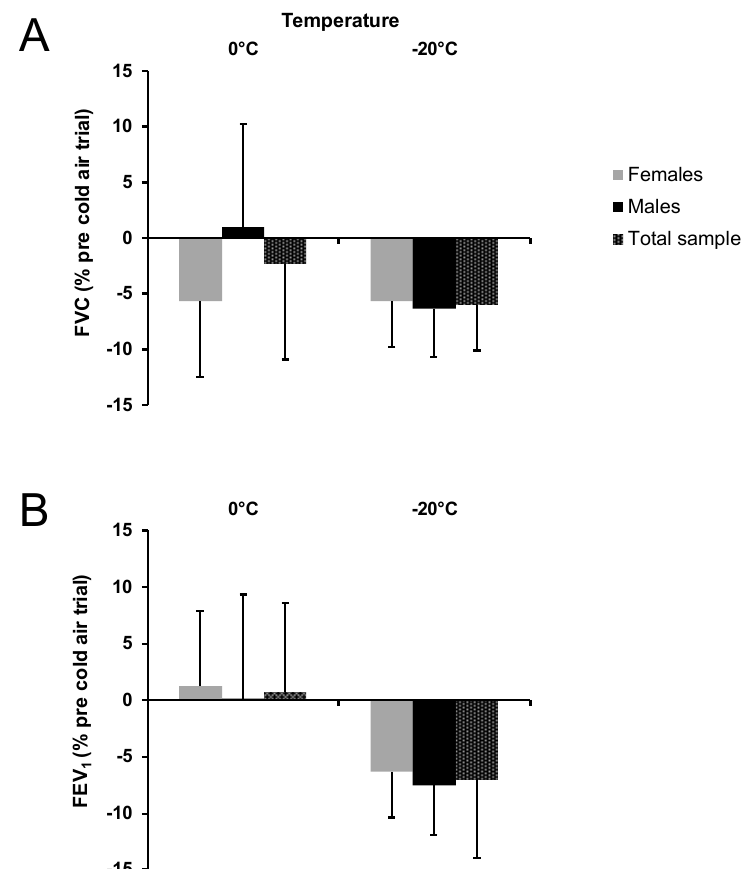
Figure 2. Acute respiratory function changes FVC ( A ) and FEV 1 ( B ) expressed as % from pretrial values for the total sample and separately for females and males at 0 °C and at −20 °C. Negative values showed a decrease from pretrial values. FVC, forced vital capacity; FEV 1 , forced expiratory volume in 1 second; error bars indicate standard deviations.